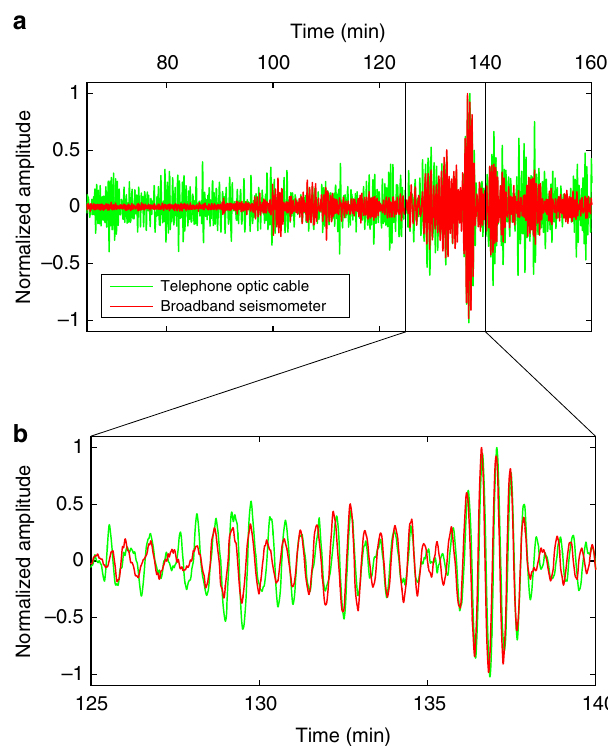
Fig. 3 Record of a teleseism earthquake with DAS. a Normalized strain (green curve) recorded during an Mb ~6.2 (USGS) earthquake (Kota Ternate, Indonesia, 2015-03-17 22:12:28 UTC, 1.669°N; 126.522°E, 44 km depth) superimposed with the normalized velocity record (red curve) from the broadband station RAH (80 m from the optical cable). Data are fi ltered between 16 and 50 s corresponding to highest amplitudes for surface waves of remote earthquakes. b Zoom from a showing good phase correspondence between seismometer velocity record and DAS